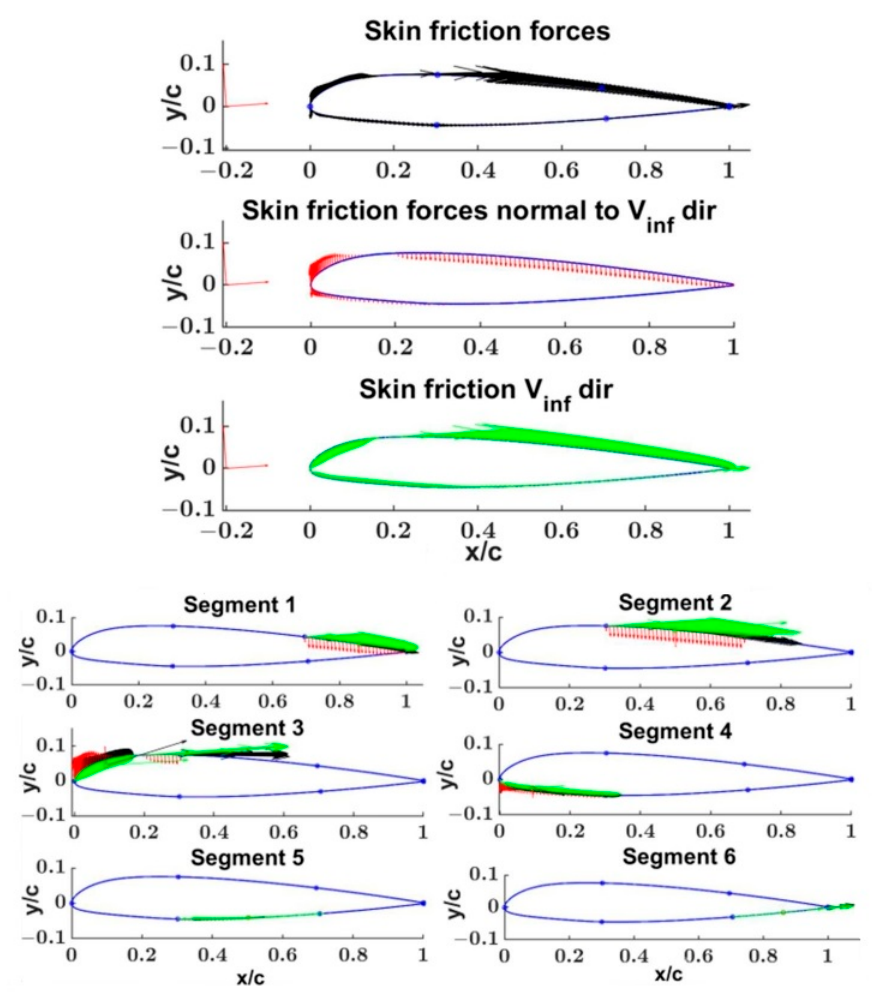
Figure 28. NACA 23012 skin friction forces along V inf and ⟂ V inf directions — segment-wise contri- bution.